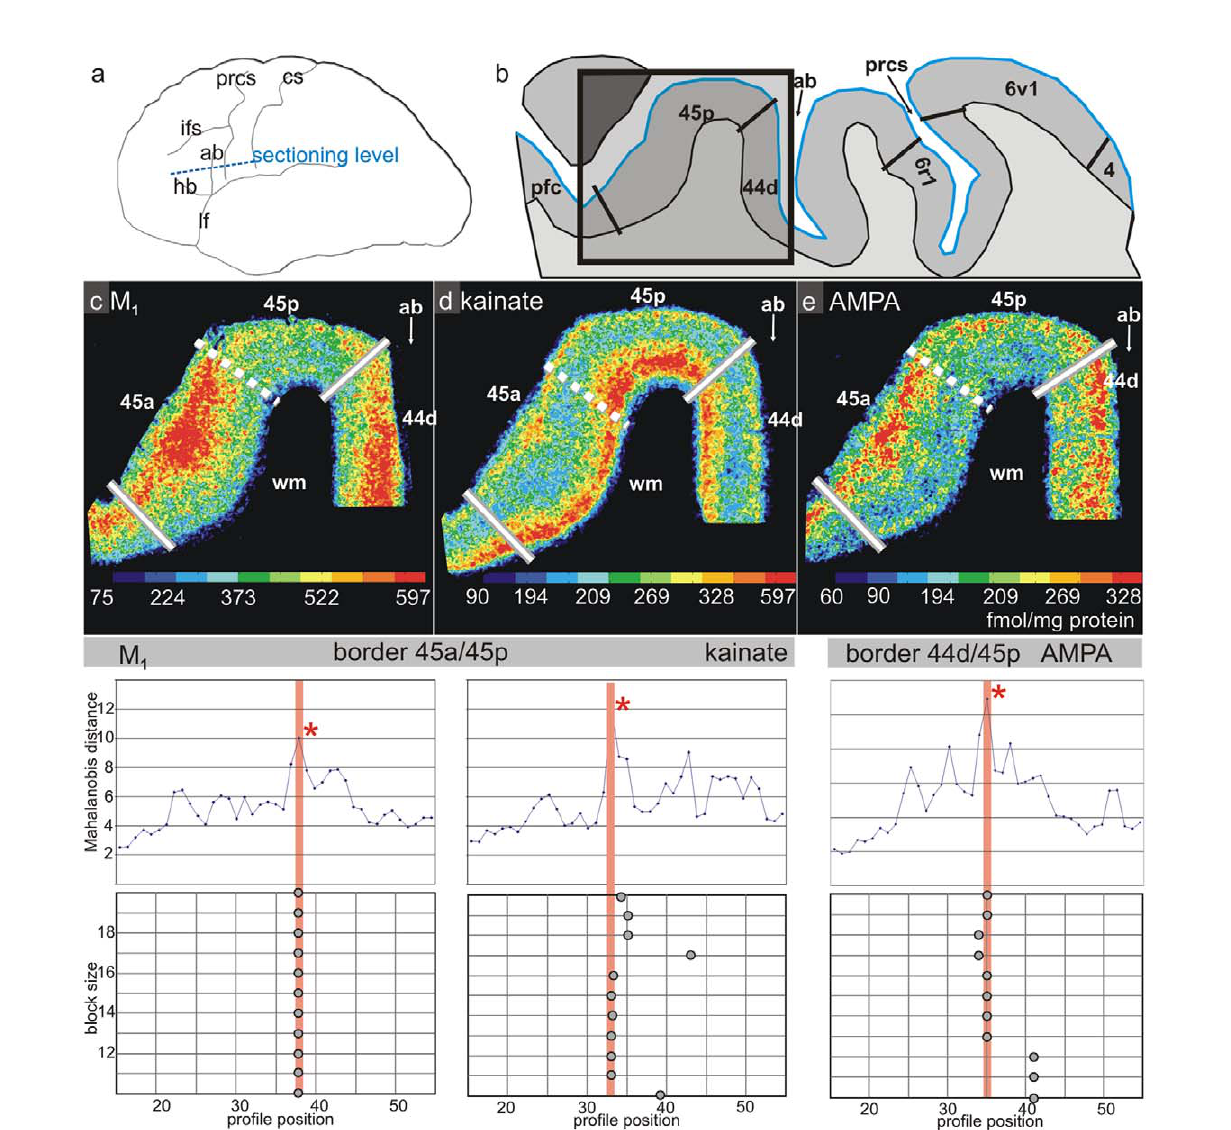
Figure 5. Receptor distributions of the cholinergic M 1 , and the glutamatergic kainate and AMPA receptors in a horizontal section. The border between areas 44 and 45 is characterized by a decrease in densities of M 1 and AMPA receptors in the more superficial layers in area 45 as compared to 44, and an increase of kainate receptor density in 45. A subdivision of area 45 is indicated, dividing it into an anterior (a) and a posterior (p) part. This subdivision is indicated by differences between both areas in M 1 and AMPA receptor densities in the more superficial layers. The graphs below show the Mahalanobis distance functions (block size of n =14 profiles) together with the dependency of the location of main maxima on the block size for the border between areas 45a and 45p (M1 and kainate receptors), as well as for the border between areas 44 and 45p (AMPA receptor). Designation as above. Dotted white lines indicate the receptor architectonic subdivision of area 45. ab, ascending branch of the lateral fissure; cs, central sulcus; prcs, precentral sulcus; tr, triangular part of the inferior frontal gyrus.